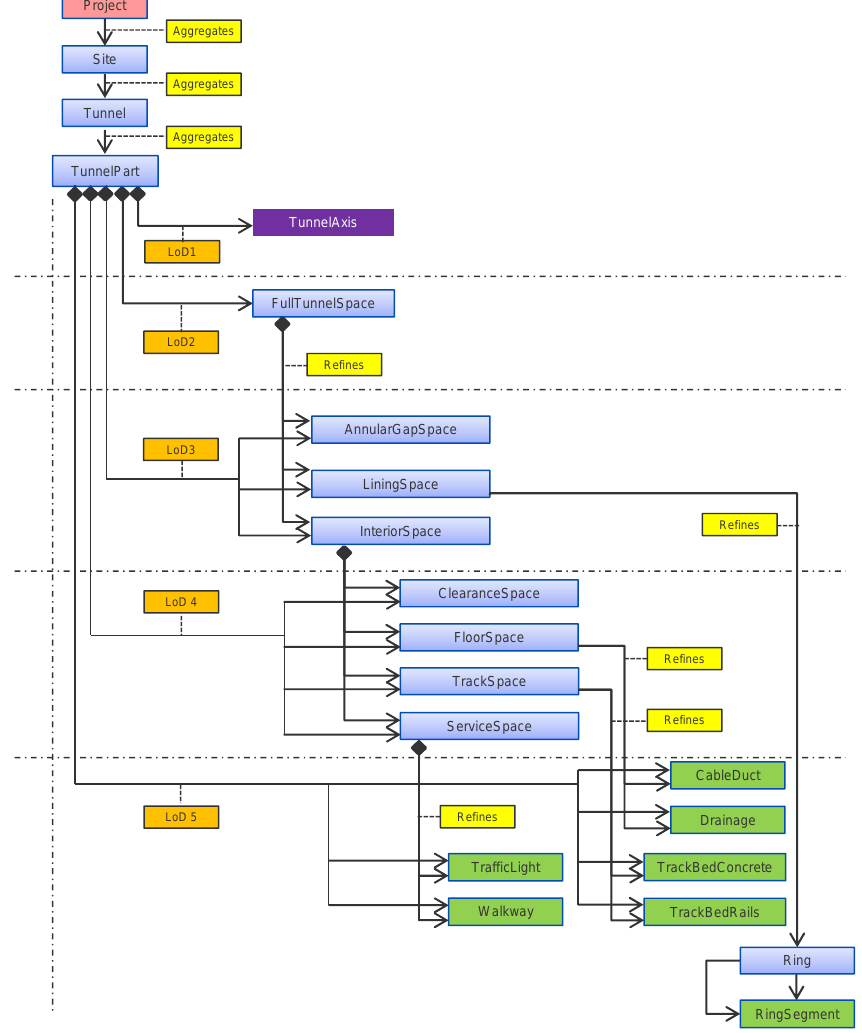
Figure 8. UML instance diagram showing the semantic part of the proposed shield tunnel product model incorporating a multi-scale representation. The TunnelPart object is associated with the different representations via dedicated LoD objects. The proposed tunnel models consists of space objects (depicted in blue) and physical objects (depicted in green). Refinement Figure 9. UML class diagram depicting the introduced relationship classes Refines and LoD, as well as the classes TunnelSpace and relationships are explicitly modeled across the LoDs. Implementing the Matyroshka principle, the spaces on a finer level TunnelInstallation which are used to model tunnel-specific spaces and installations. Classes depicted in blue are are fully included in the corresponding space on the coarser level. Physical objects are modeled only on the finest subclasses of SpatialStructureElement, classes depicted in green are subclasses of Element and represent physical objects. Relationship classes are depicted in yellow.